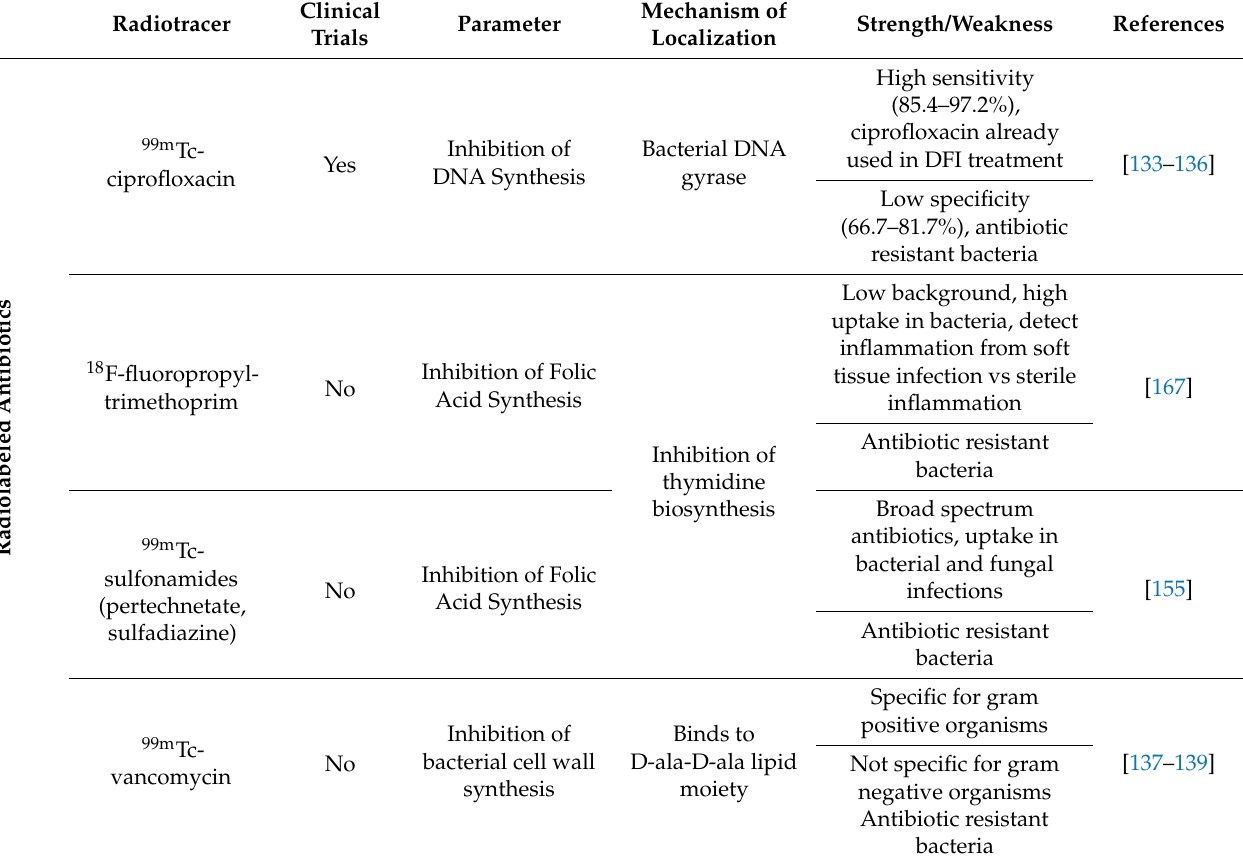
Table 4. Emerging Investigational Radiotracers of Infection